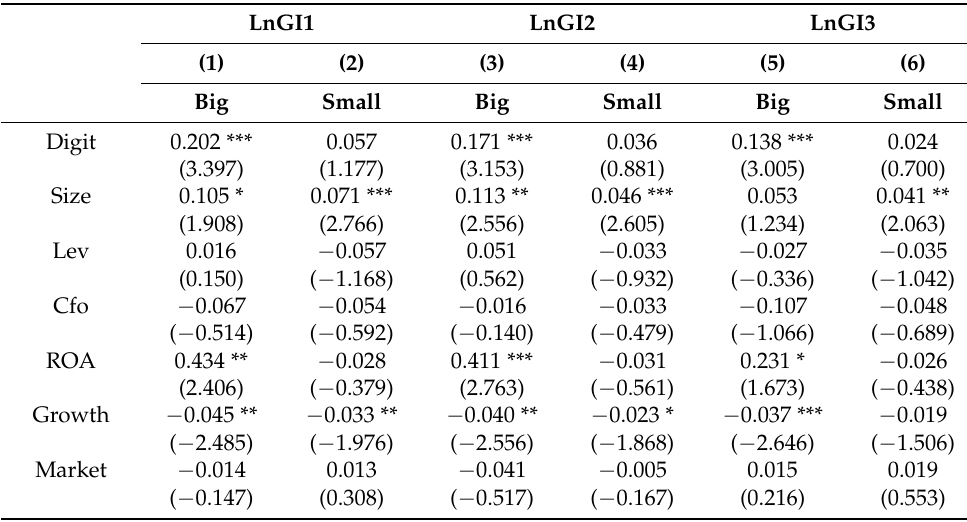
Table 10. Heterogeneity test for firm